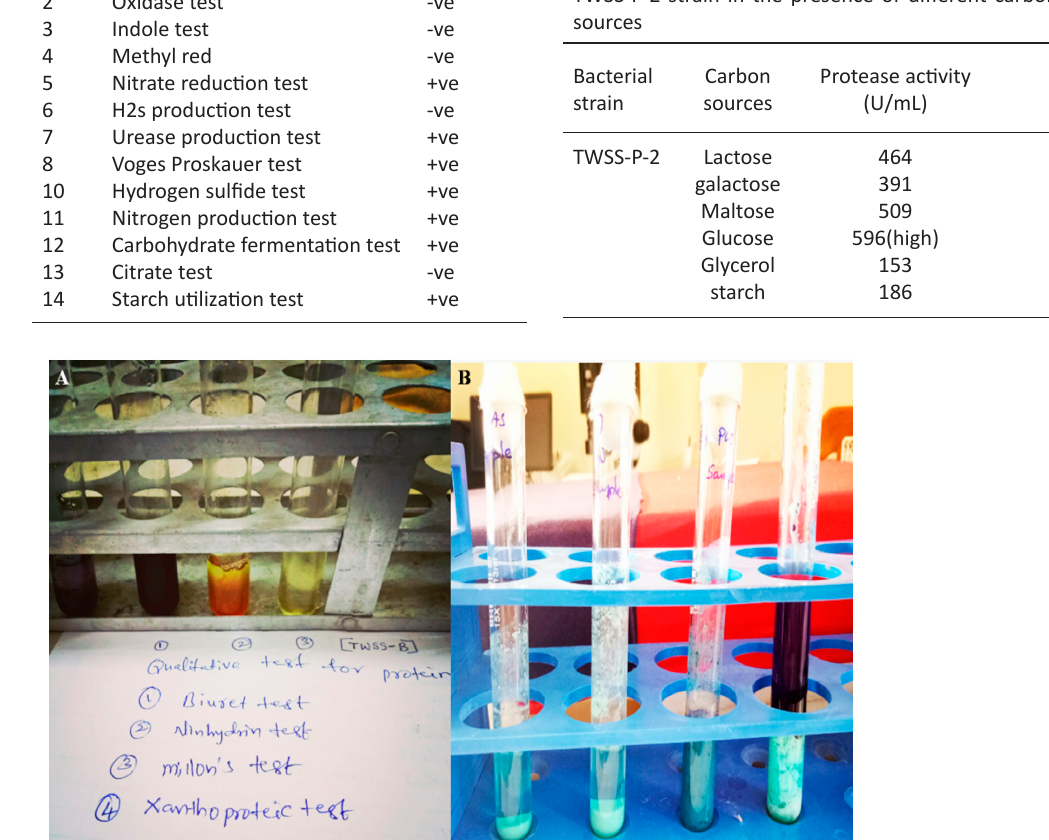
Table 3. Estimated protease activity of the selected